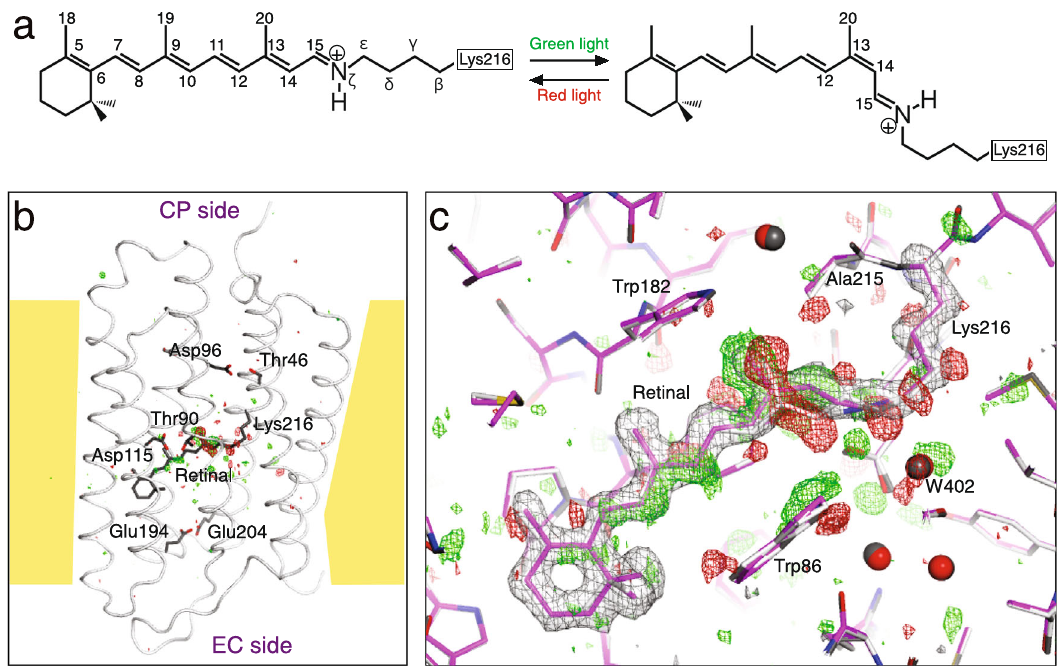
Fig. 1 Structural analysis of the K intermediate of bR. a Photoisomerization of retinal. All- trans retinal, which is linked with Lys216 of bR via the SB linkage, isomerizes to 13- cis retinal by absorption of green light. A back reaction is caused by absorption of red light. b A whole view of the F (K + bR) − F (bR) difference map. The difference electron densities at the + 4 σ and − 4 σ levels are shown as green and red meshes, respectively. The structure of bR is represented as a tube in gray, while retinal is shown as sticks in dark gray. c A close-up view around the retinal chromophore. The K structure is represented as colored sticks, while the ground state structure is represented as gray sticks. The F (K + bR) − F (bR) difference map is shown as green and red meshes at contour levels of ±3 σ . The omit map for retinal and the Lys216 side chain calculated from the extrapolated data is overlaid as gray meshes at a contour level of + 3 σ